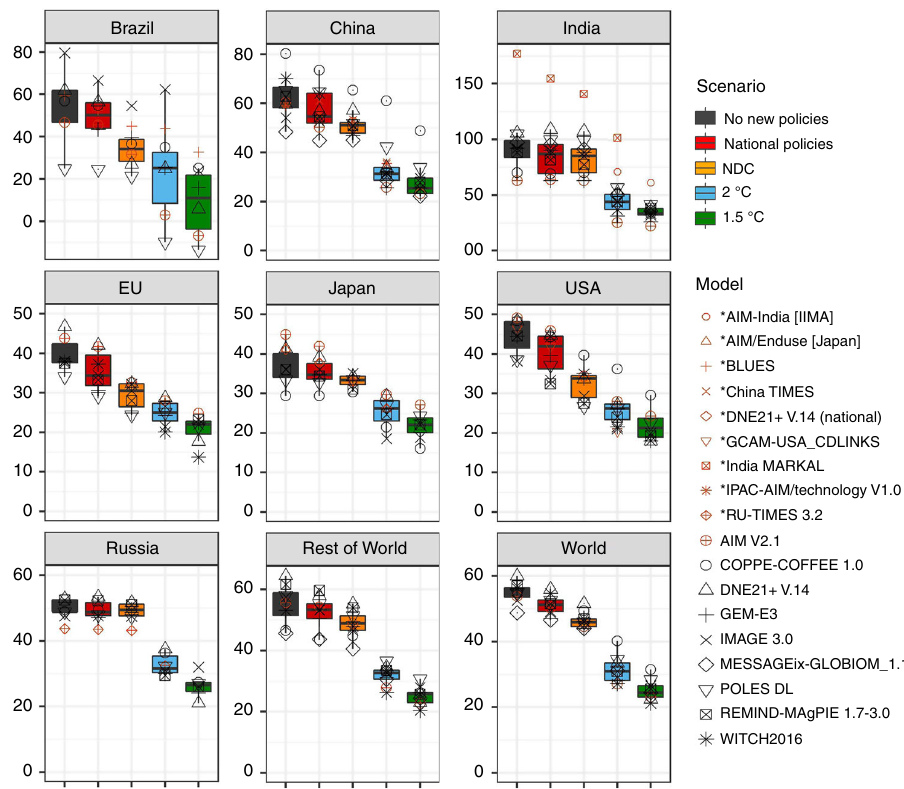
Fig. 4 Cumulative CO 2 emissions in the period 2011 – 2050 period relative to 2010 emissions on the global level and for seven large countries under different scenarios. The box plots indicate the median, 25th to 75th percentile range, while the black data points show the full global model range. The brown coloured markers indicate the results from the national models. The data is available in the source